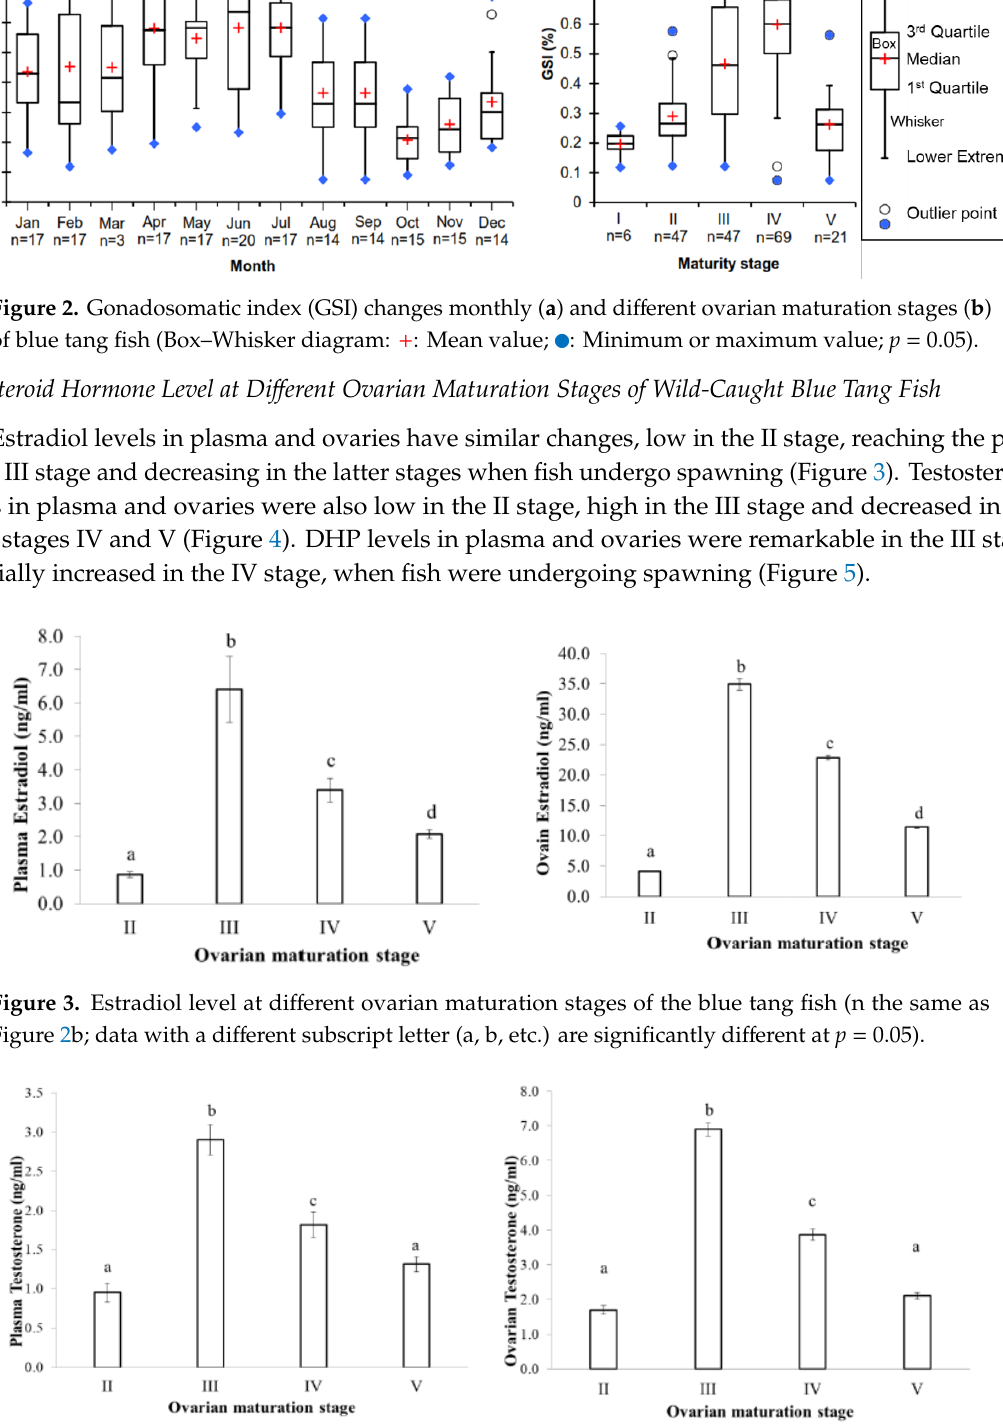
Figure 4. Testosterone level at di ff erent ovarian maturation stages of the blue tang fish (n the same as Figure 2b; data with a di ff erent subscript letter (a, b, etc.) are significantly di ff erent at p =